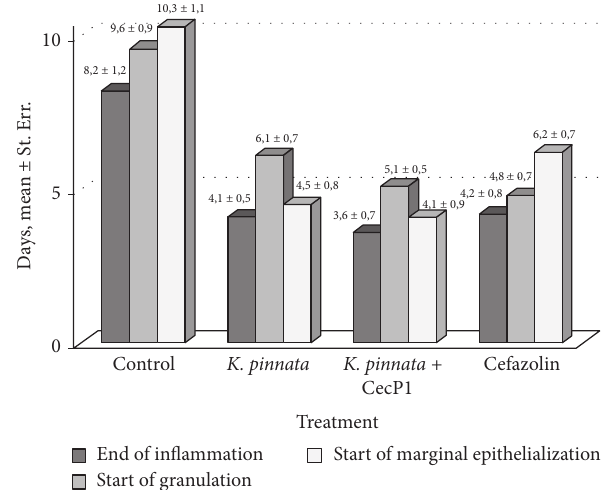
Figure 4: Testing healing of the wounds infected with S. aureus. Timing of wound recovery phases after beginning of curing (M ± Std . Err.) is shown.